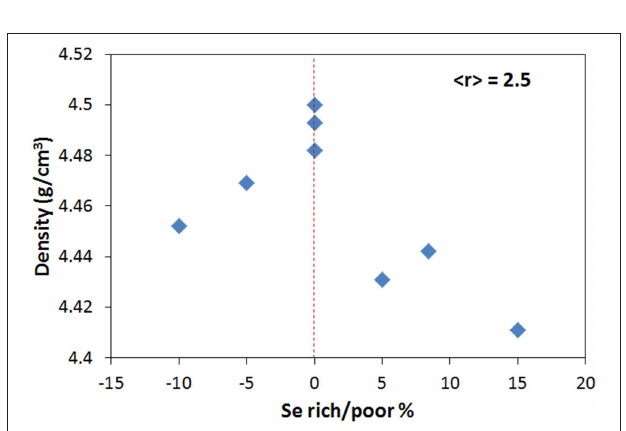
FIGURE 3 | Density of Ge-As-Se glasses with fixed average coordination of < r > = 2.5 as a function of excess/deficiency of Se in the structure.